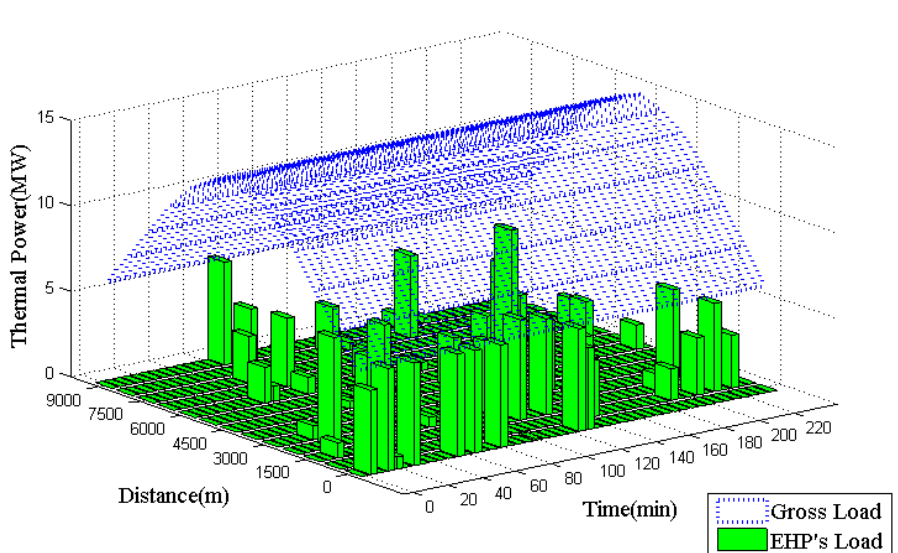
Figure 11. Configuration of Space Heating Load (COP =